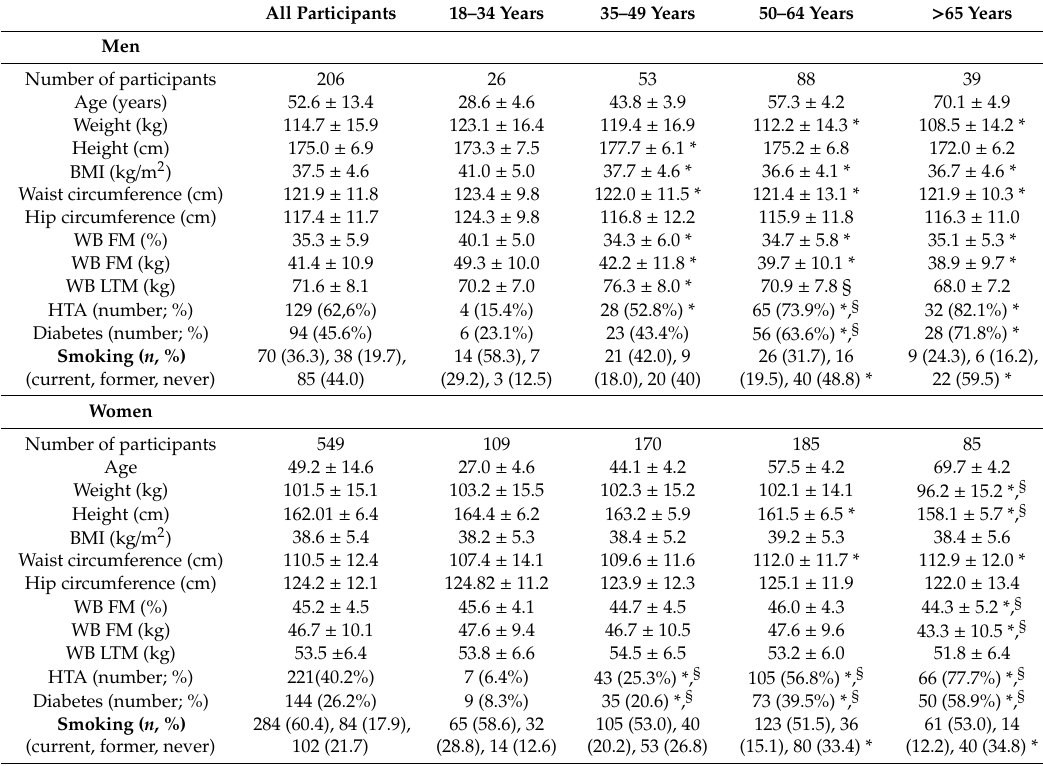
Table 1. Characteristics of the study population according to sex and age